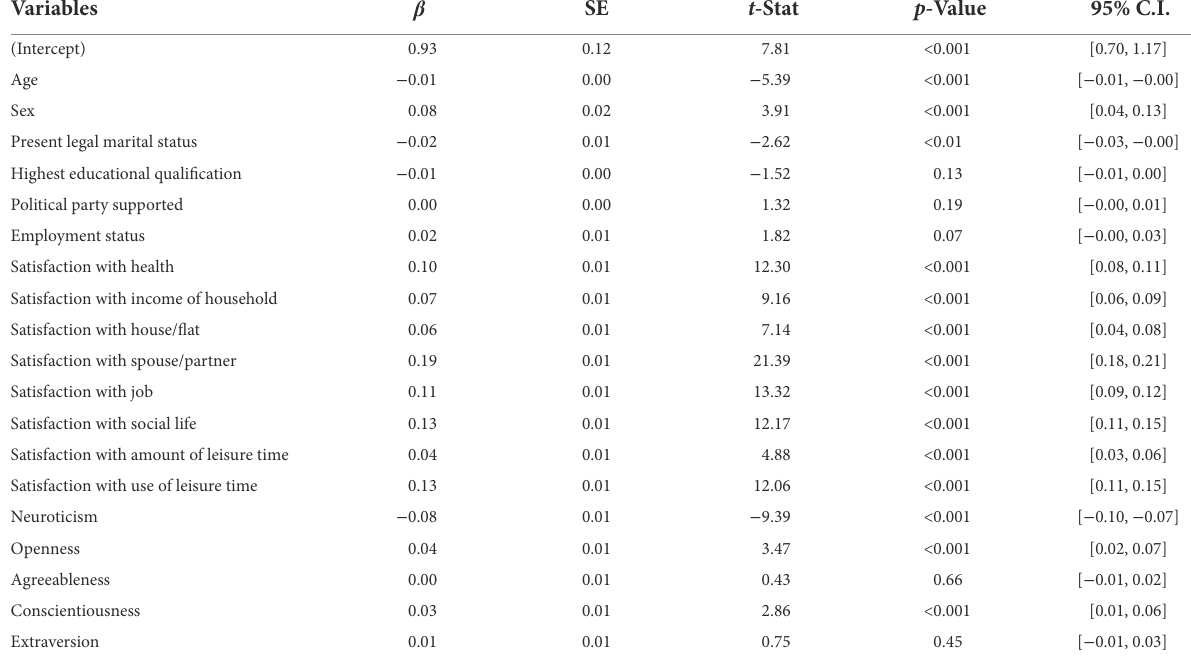
TABLE 5 Multiple regression analysis results with overall satisfaction as the predicted variable and demographics, areas of life satisfaction and personality traits as predictors.